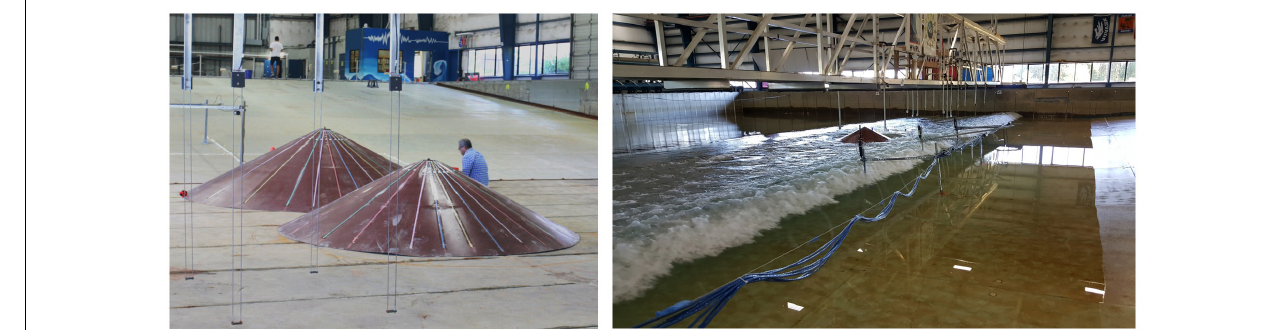
FIGURE 6 | Installation of artificial islands (left) and tsunami tests in DWB (right) .